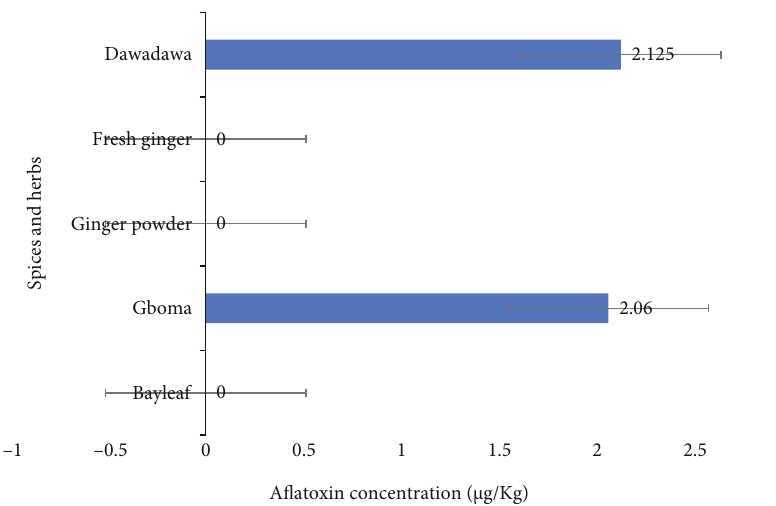
Figure 5: Mean a fl atoxin concentrations in spices and herbs of samples from the Ho Table 5: pH of spices and herbs from the Ho municipality. Sample Mean ± std